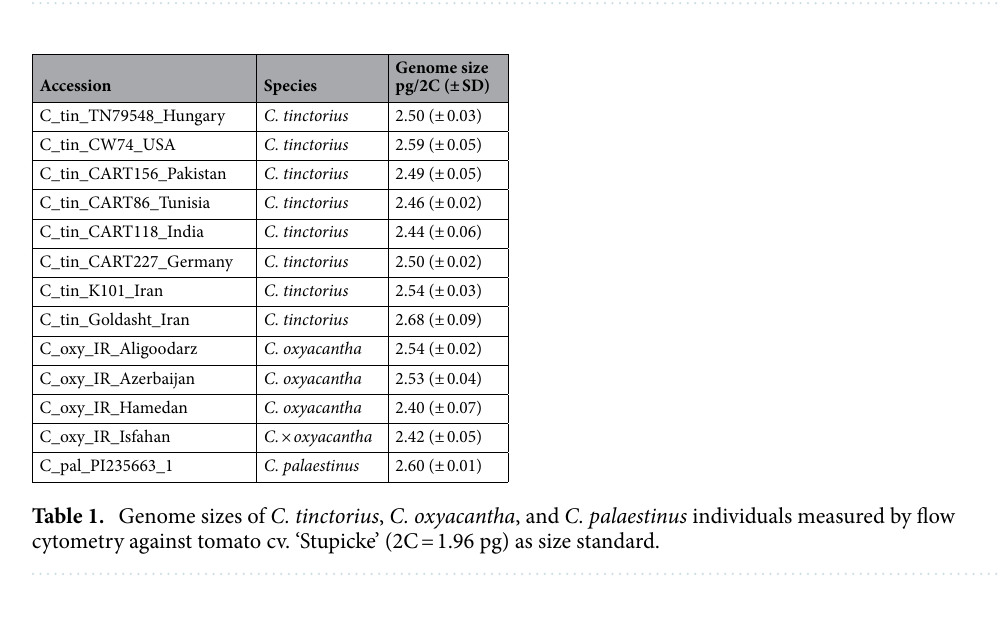
Figure 6. Population structure analysis based on 7556 unlinked SNPs in LEA with K = 5 for C. tinctorius and C. palaestinus individuals.